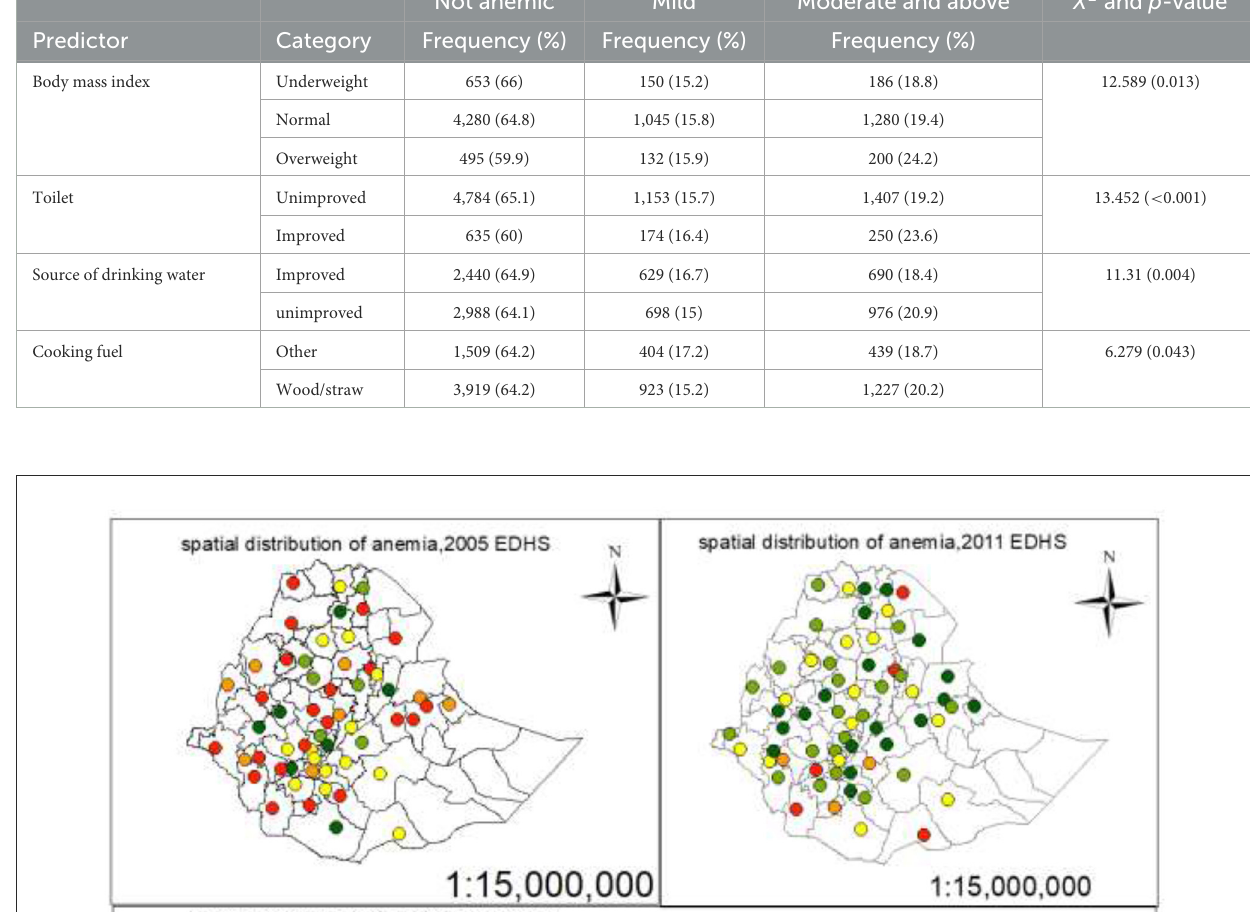
Where ρ W y is a form of auto-covariance and is a weighted average of the number of events among the ki neighbors. The weighting of the average location of the ijth is through W ij = 1/h ij where h ij is the Euclidean distance between the village i and j. ˆ y i is the alleged existence of an event and β is the regression coefficient. The data were analyzed on SAS version 9.4 with Proc logistic command; ArcGIS version 10.4, and SPSS version 26 were used in the data